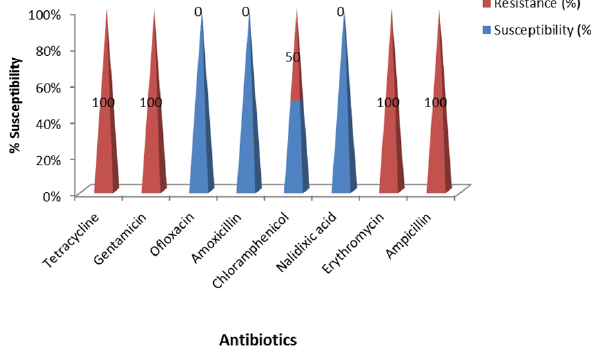
Fig. 3. Antibiogram of E. coli isolated from cow dung used to fertilize fish ponds in New Bussa Nigeria